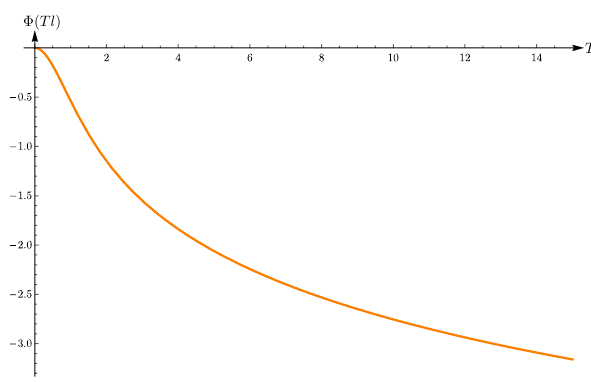
Figure 8 . Plot of Φ( Tl ) in eq. (4.17), which gives the temperature dependence of the complexity of the